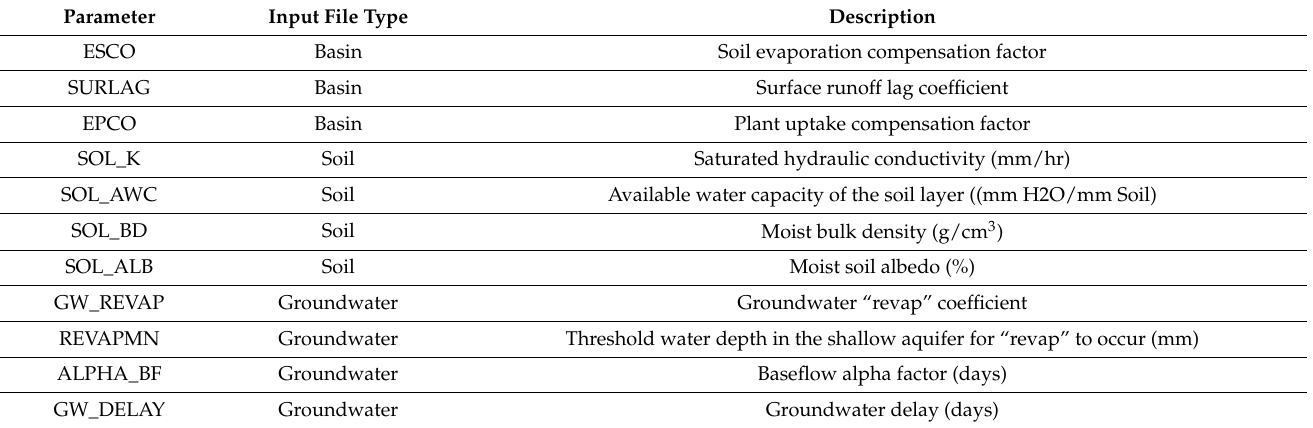
Table 2. The initial list of parameters used for sensitivity